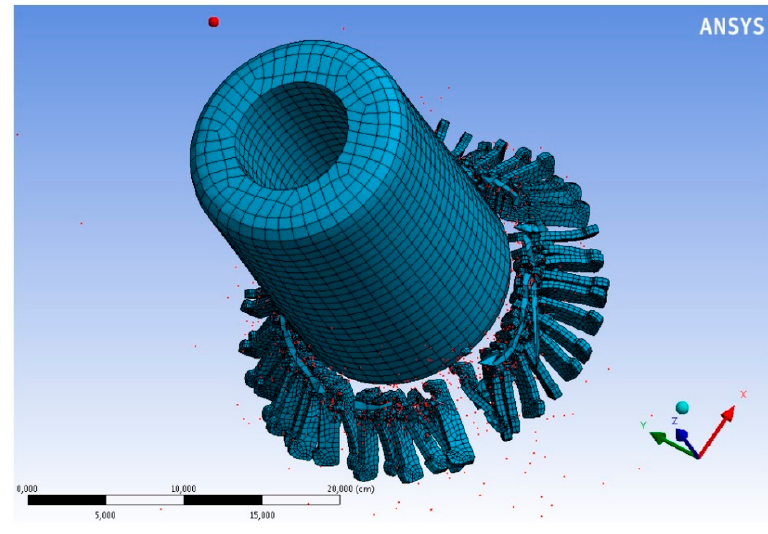
Figure 23. Destruction of the entire contact system.